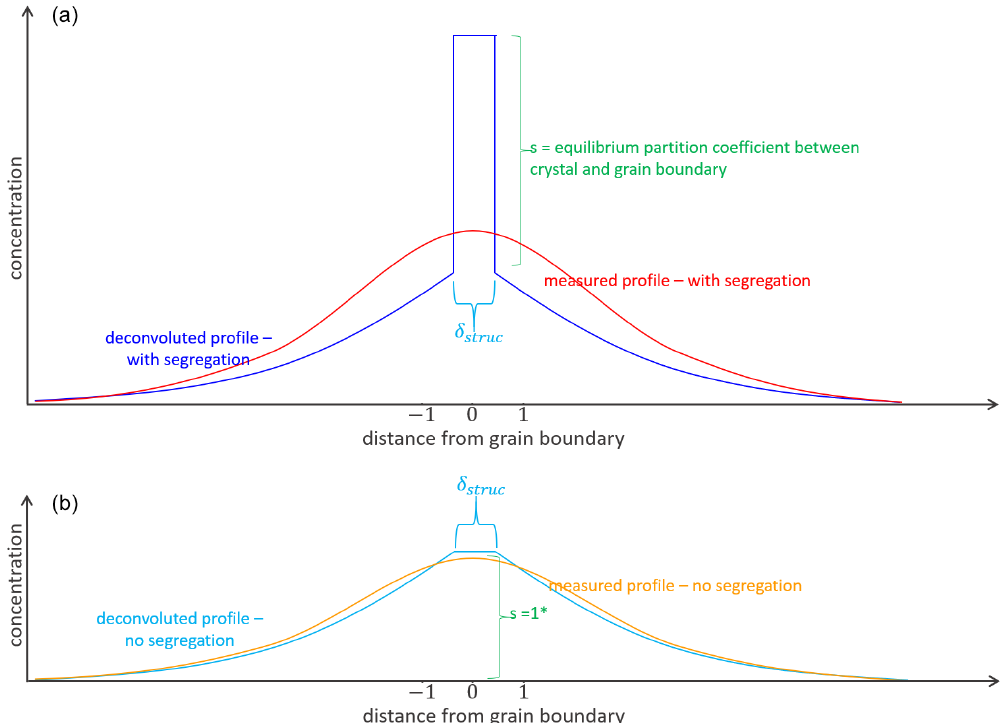
Figure 12. Concept of diffusion profile shapes with segregation (a) and without segregation (b) . δ : structural grain boundary width, s : segregation coefficient. The blue lines in upper and lower image illustrate idealized concentration distribution across the grain boundary without any convolution effect, the red and orange lines indicate the concentration distribution of measured profiles and show the effect of convolution, for example spatial resolution. * Analytical grain boundary diffusion solution of Whipple and Le Claire (Le Claire, 1963; Whipple, 1954); s = 1.